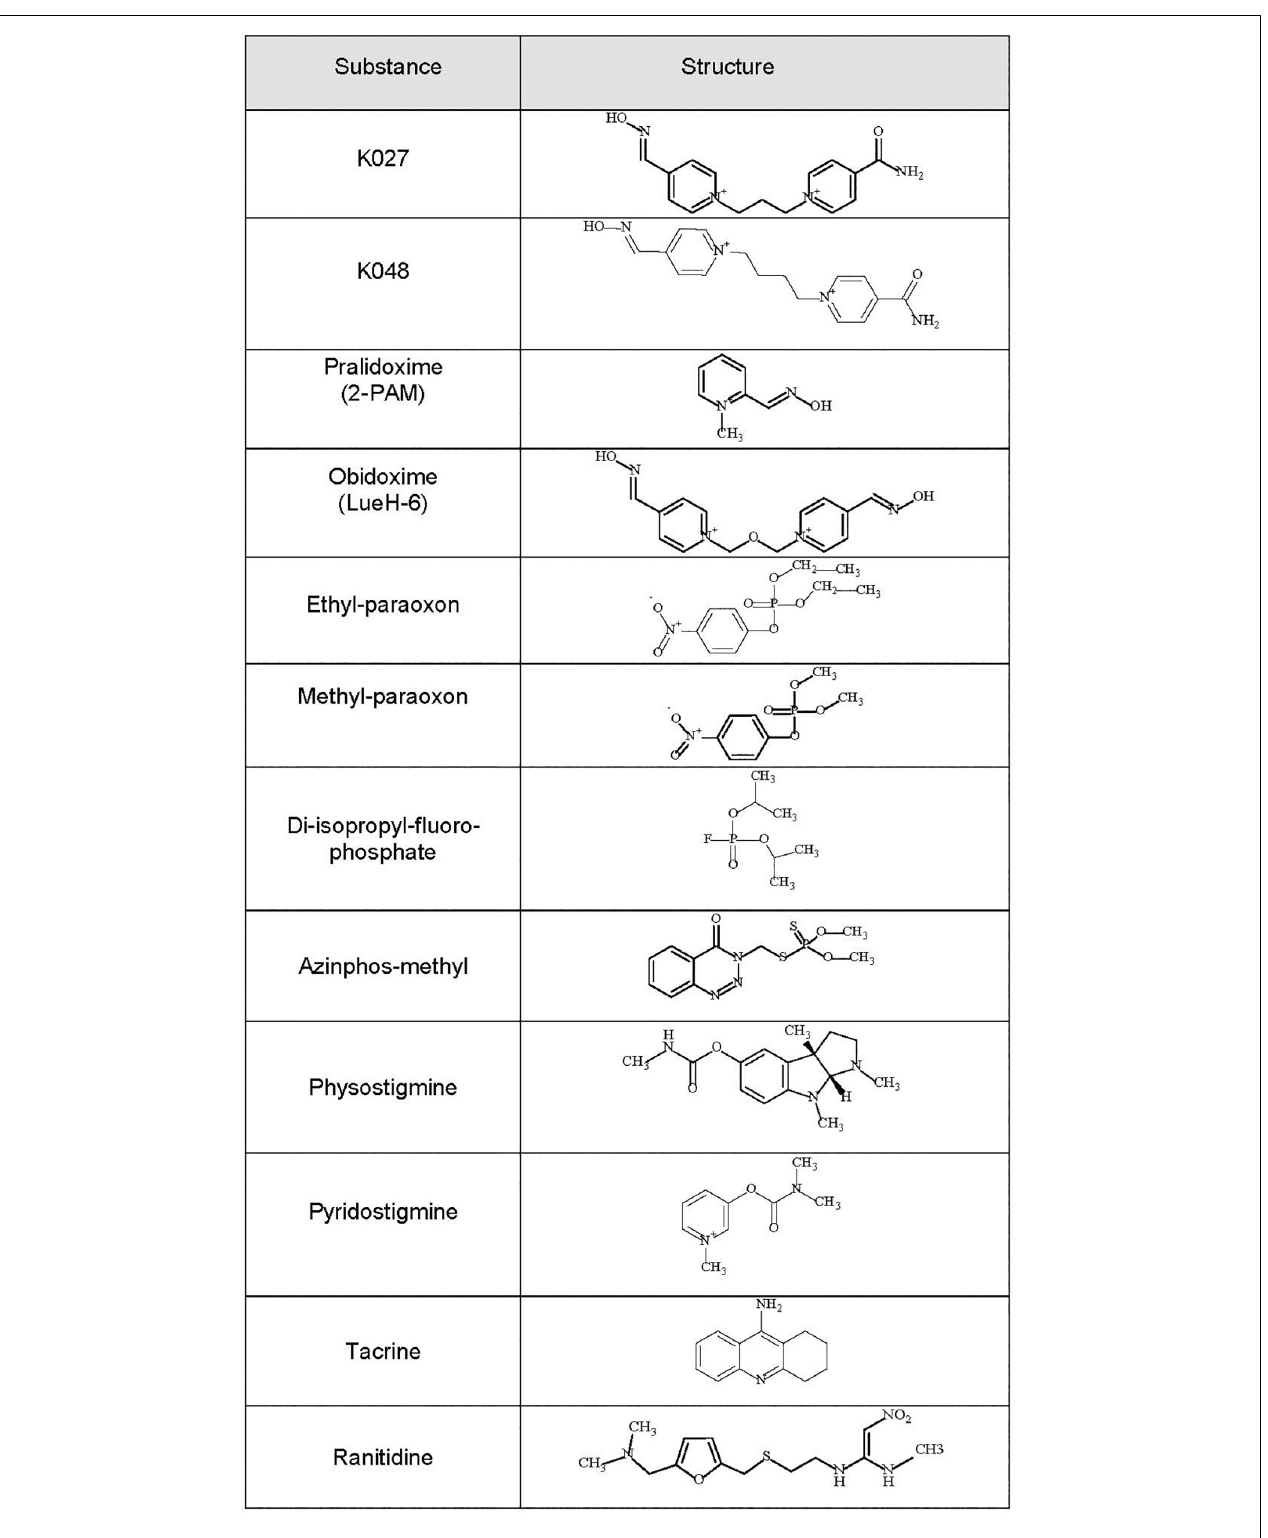
FIGURE 1 | Chemical formulas of the experimental K-oximes K027 and K048, the established oximes pralidoxime and obidoxime, the organophosphorus compounds (OPCs) diisopropylfluorophosphate (DFP), ethyl-paraoxon, methyl-paraoxon, and azinphos-methyl, and the reversible acetylcholinesterase (AChE) inhibitors physostigmine, pyridostigmine, tacrine, and ranitidine.